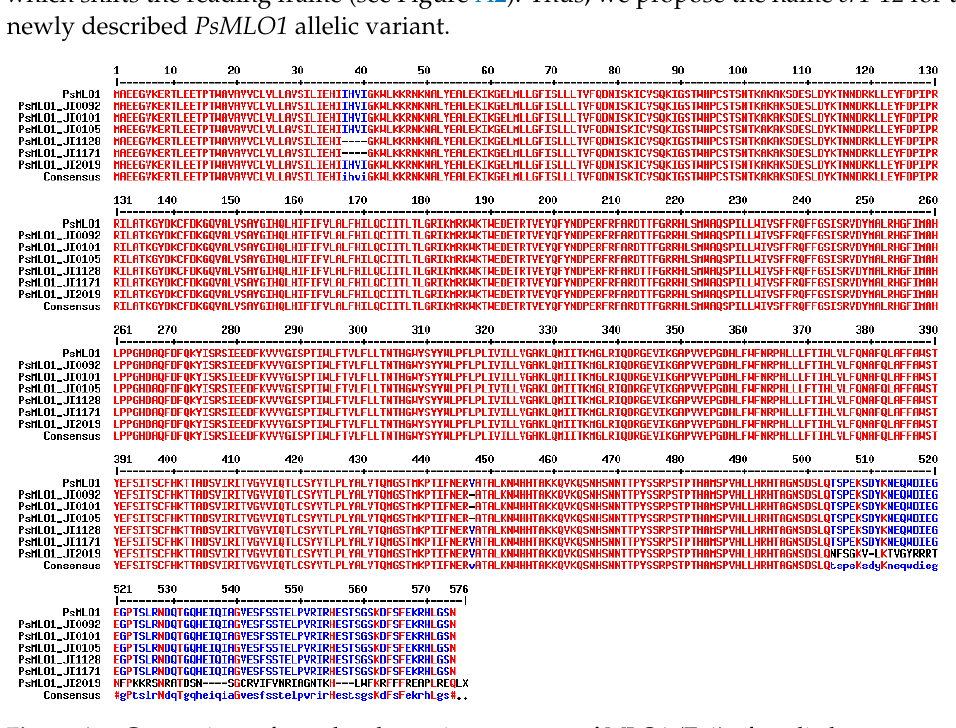
Figure A2. Comparison of translated protein sequences of MLO1 (Er1) of studied pea genotypes (obtained via Multalin web service [173], http://multalin.toulouse.inra.fr/multalin/multalin.html).